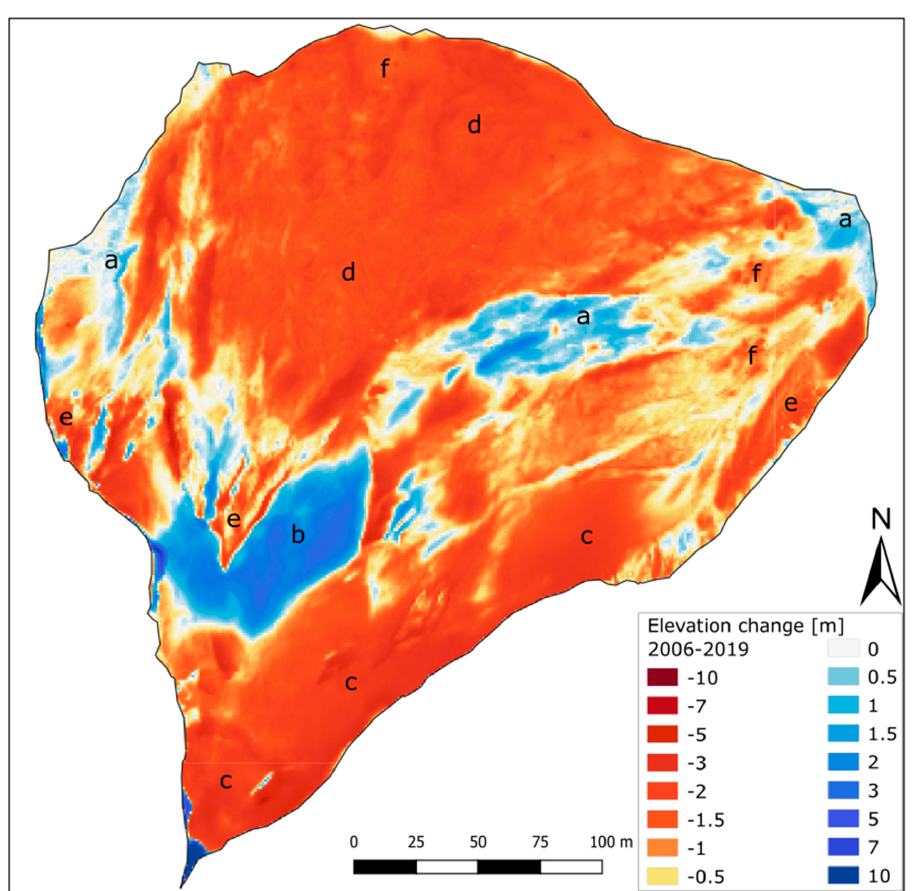
(c) or ice melt below a thick debris cover (d) in the lower zone; areas showing inhomogeneous lowering Figure 5. Spatial extent of substrata covering the Montasio Glacier at the end of the ablation season in three different years: ( a ) 2006, ( b ) 2010, and ( c ) 2019. represent gully erosion (e), and small sinkholes (f).